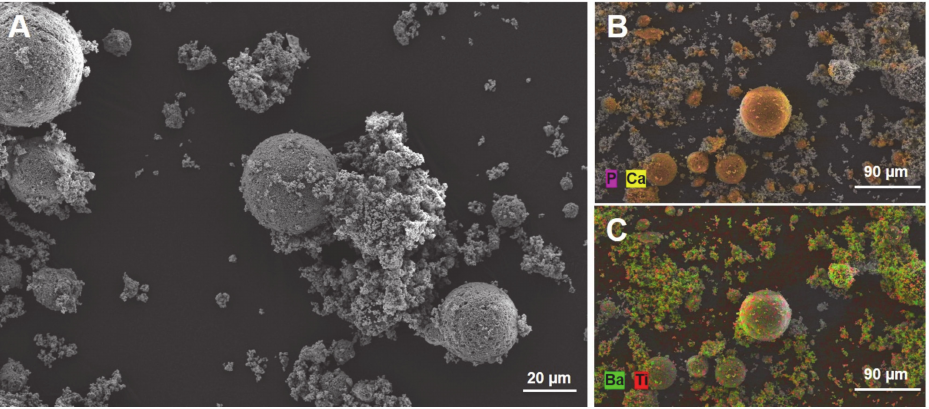
Figure 4. SEM image of the BaTiO 3 / HA powder mixture used for the 3DP process ( A , scale bar: 20 µ m). Elementary classification by EDX spectroscopy for HA ( B , scale bar: 90 µ m) and BaTiO 3 ( C , Scale bar: 90 µ